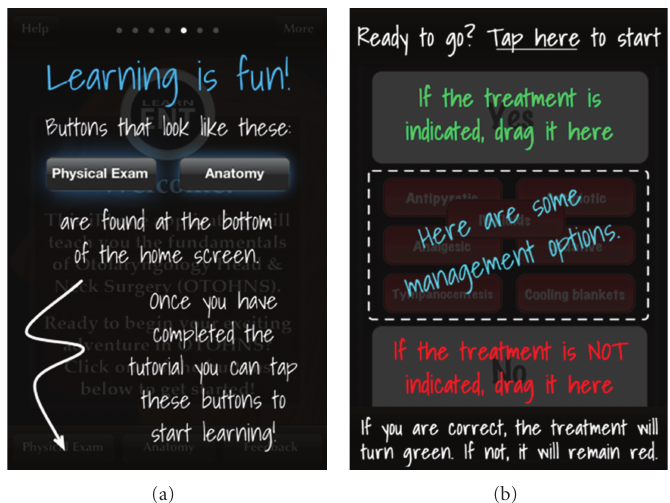
Figure 5: (a) Part of a short, interactive tutorial that automatically appears the first time the app is launched. (b) clear instructions for one highly interactive